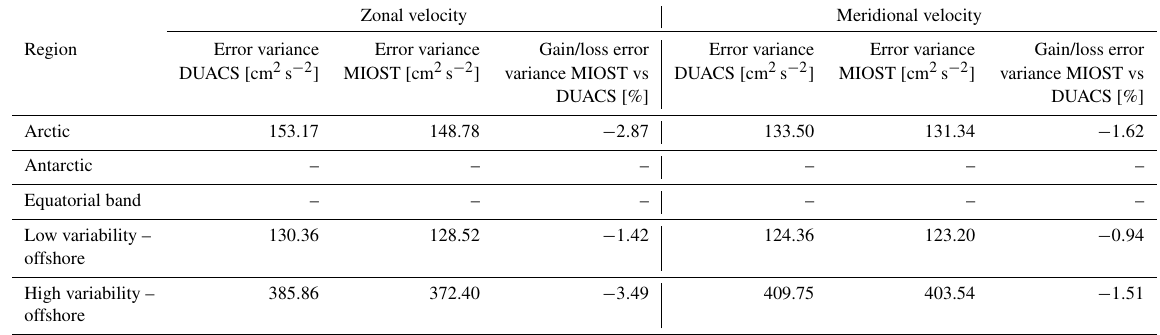
Figure 9. Variance of the difference U map − U drifter computed for the DUACS allsat-1 experiment and in considering (a) the zonal velocity component and (b) the meridional velocity component. Gain/loss of the mapping error variance of currents in the MIOST allsat-1 experiment relative to the DUACS allsat-1 mapping error variance for (c) the zonal velocity component and (d) the meridional velocity component. Blue colour means a reduction of error variance in MIOST. Table 5. Regionally averaged mapping error variance and gain/reduction of error variance on the surface currents between MIOST and